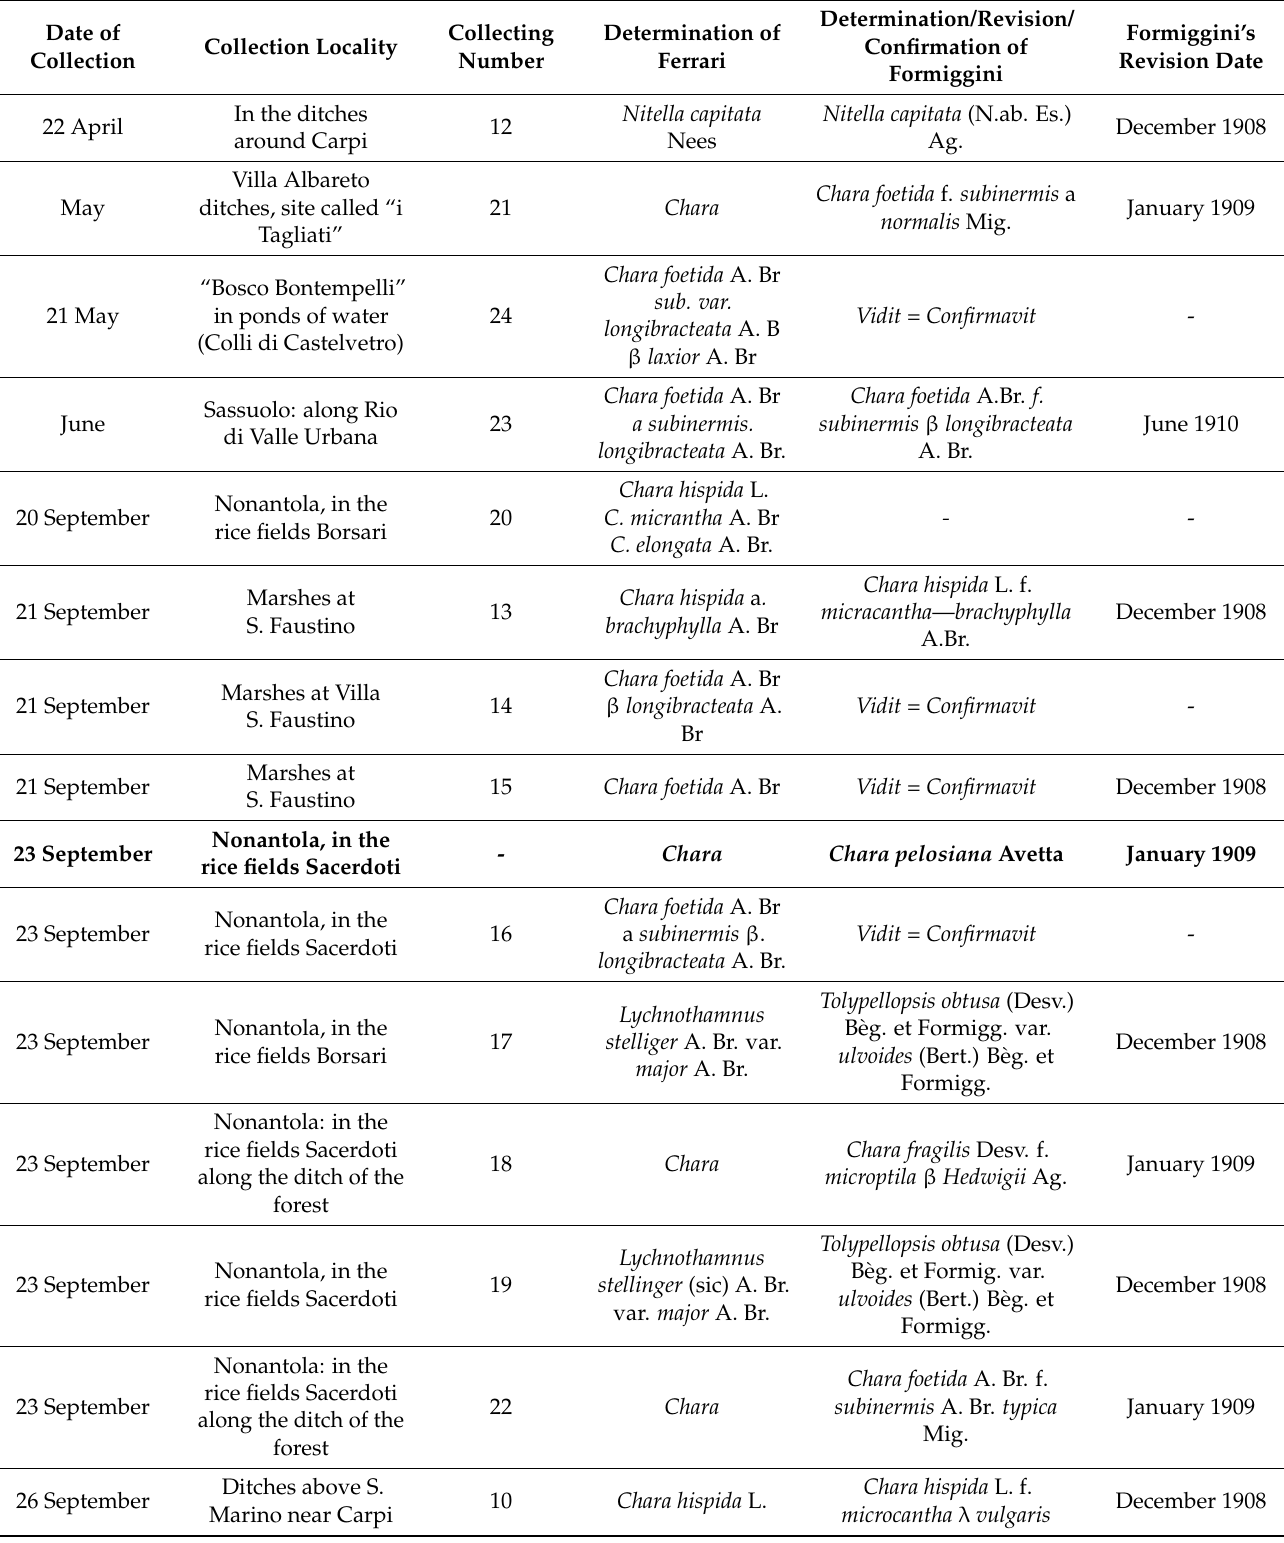
Table 2. Duplicate of Ferrari’s Characeae collection from the Turin Herbarium (TO). The specimens, collected in the Modena area in 1886, are listed in chronological order. For the abbreviations of names and authors, we reproduced the original labels. The two specimens of Chara pelosiana revised by Formiggini are marked in